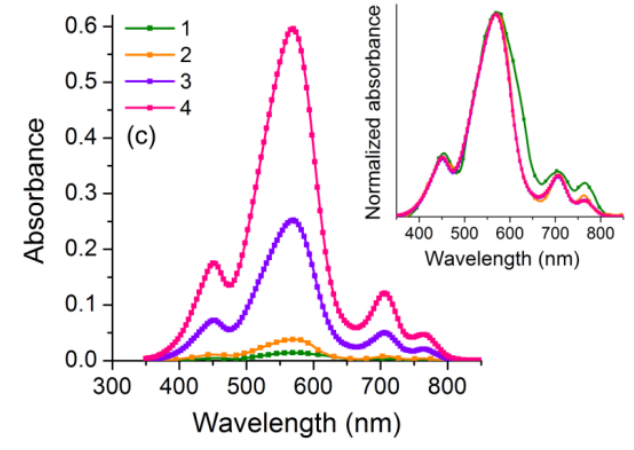
Figure 2. Normalized UV-Vis absorption spectra of heptamethine cyanine dyes ( a ) 8a and ( b ) 8b in a solution of different organic solvents (~10 − 6 M) and ( c ) cyanine dye 8b in acetonitrile at different concentrations (1:5.0 × 10 − 7 M, 2:1.0 × 10 − 6 M, 3:5.0 × 10 − 6 M, and 4:5.0 × 10 − 5 M). The inset shows the respective normalized UV-Vis spectra. (DCM = dichloromethane).